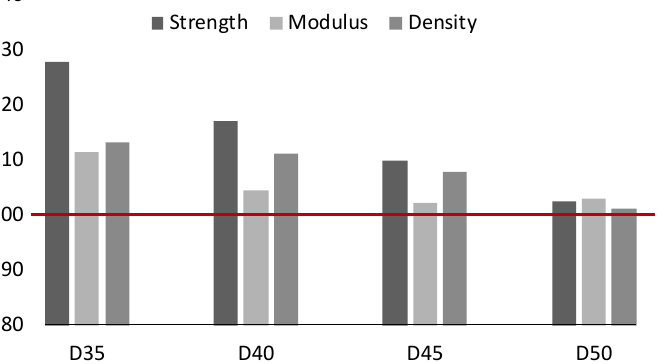
Figure 1. Ratio between the characteristic values achieved by the pieces graded by machine (using the dynamic modulus of elasticity) and the requirements for the classes (combinations with only one class).